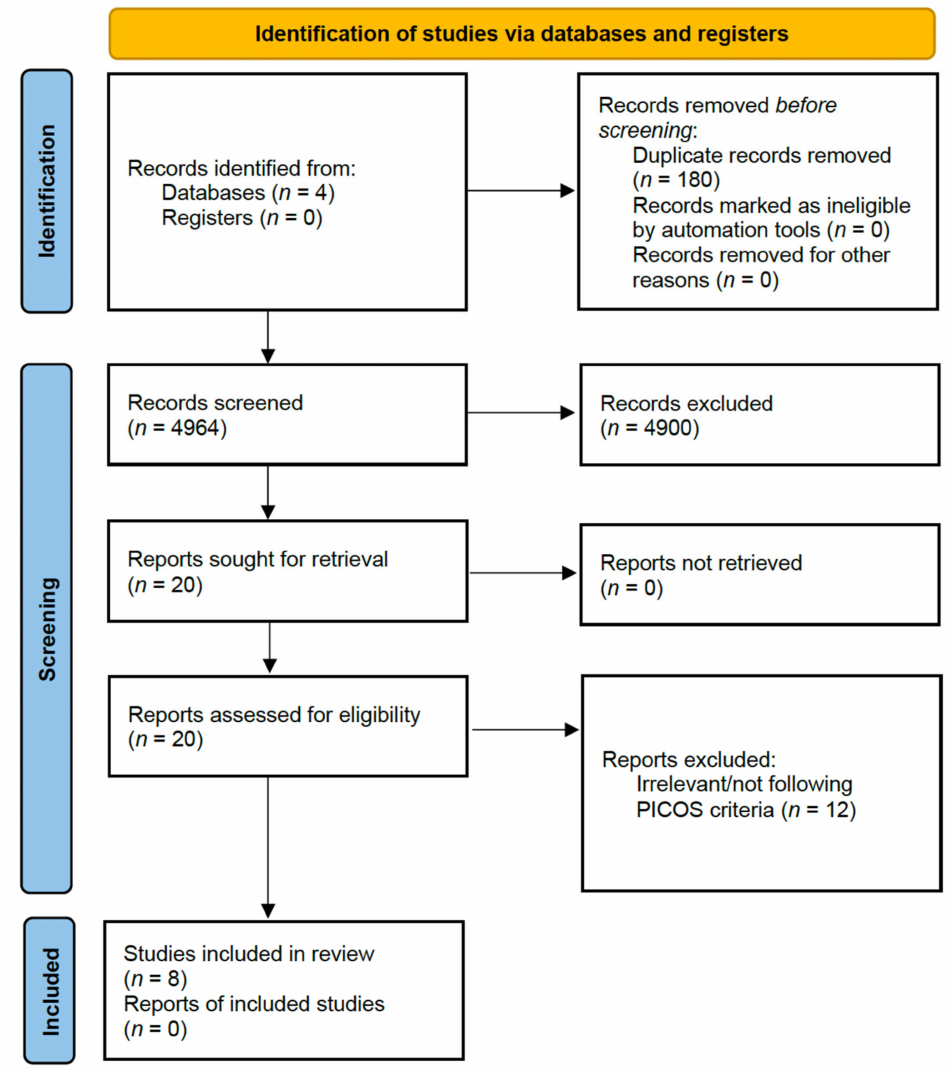
Figure 1. PRISMA flow diagram of the